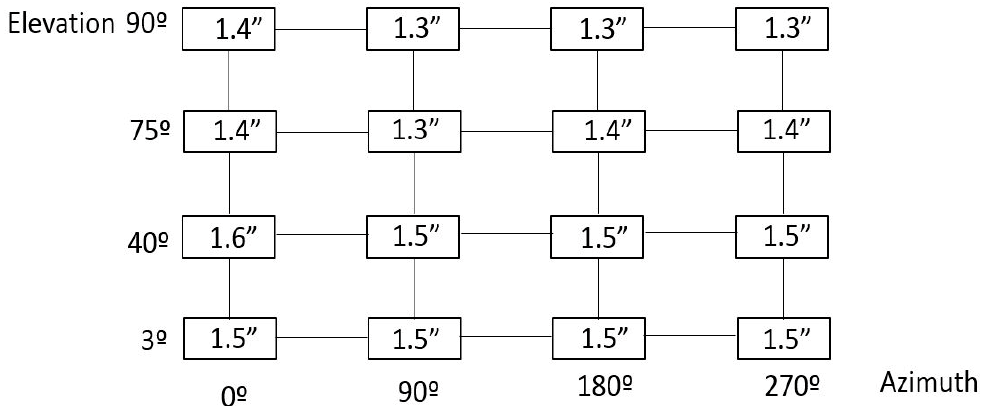
Figure 12. Alignment parallelism uncertainty results under stable floor conditions (in arcseconds). Table 1. Floor movement alignment parallelism simulation (in arcseconds).